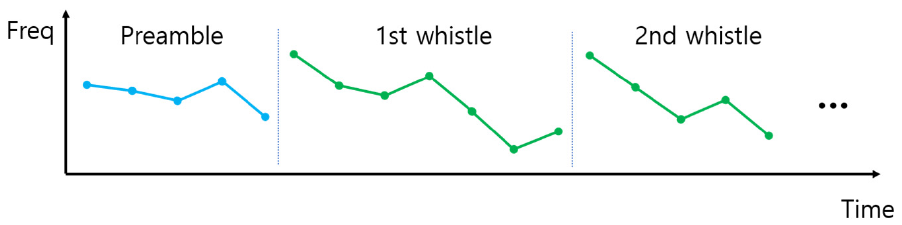
Figure 6. The frame structure of the proposed biomimicking signal.